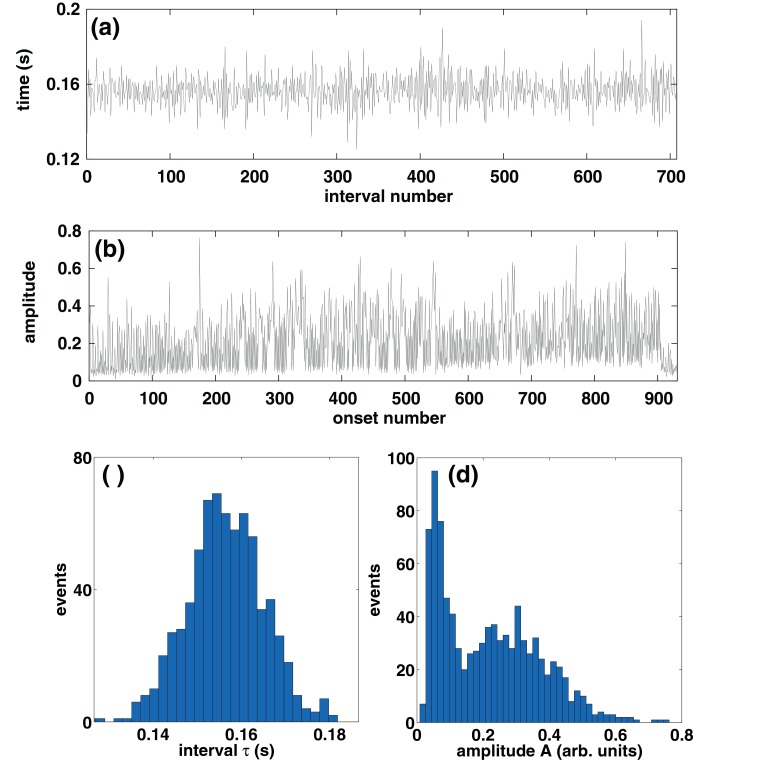
(a) Detected 16th note intervals in the song. (b) Detected onset amplitudes. (c-d) Corresponding statistical distributions of (a) and (b), respectively. The distribution of the intervals resemble a Gaussian distribution with a mean value 157 ms and a standard deviation of 8.7 ms.